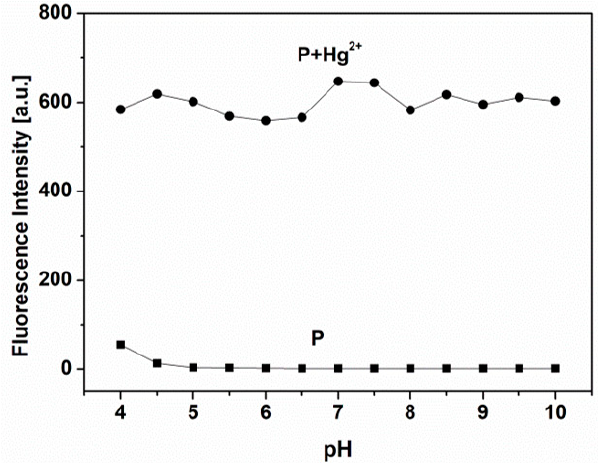
Figure 1. The effect of pH on P (5 μ M) and the P (5 μ M)-Hg 2+ (50 μ M) system ( ● ) in the aqueous media (ethanol-water, 8:2, v / v , 20 mM HEPES). The HEPES buffer was adjusted using 1.0 M HCl or 1.0 M NaOH.